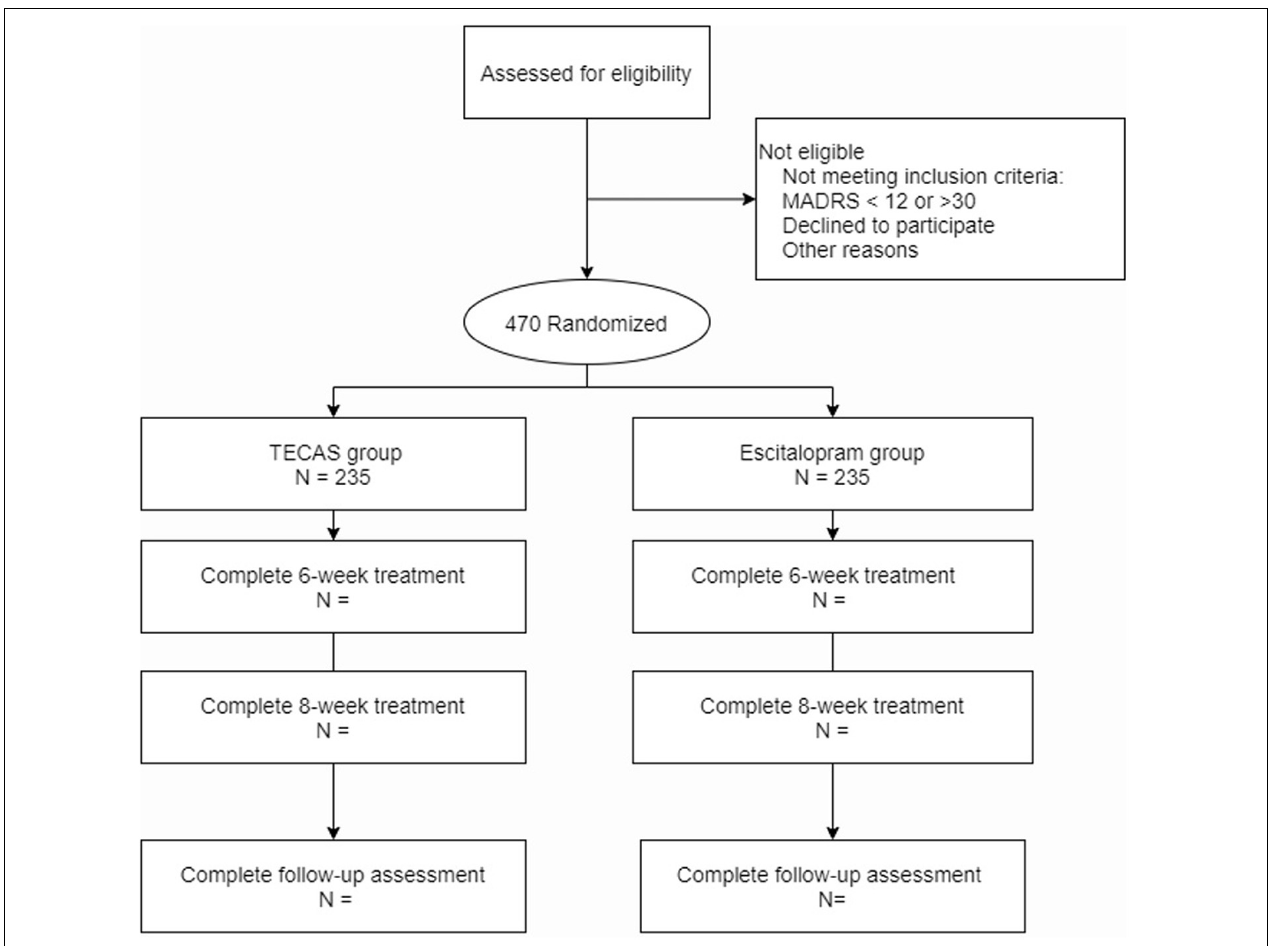
FIGURE 1 | Study flow